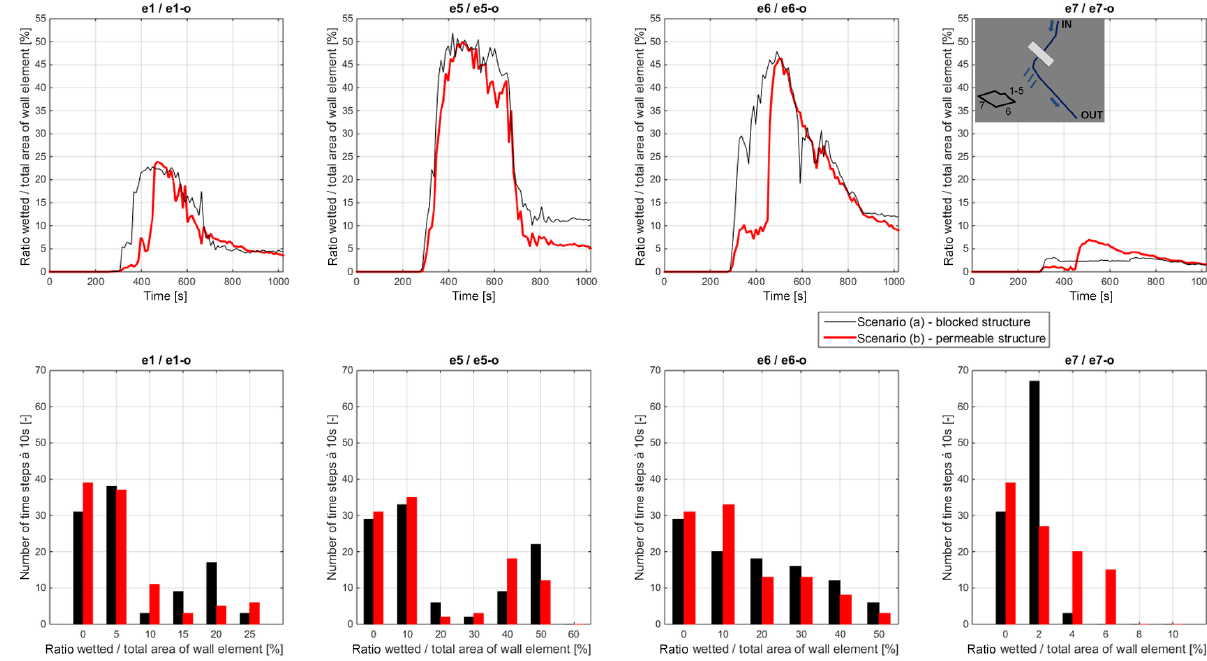
Figure 8. (Top line) ratio of wetted and total area of the wall elements e1, e5, e6 and e7 at the outside of the building for the scenarios (a) and (b); (lower line) comparison of wetting durations (number of time steps à 10s) for the considered wall elements.